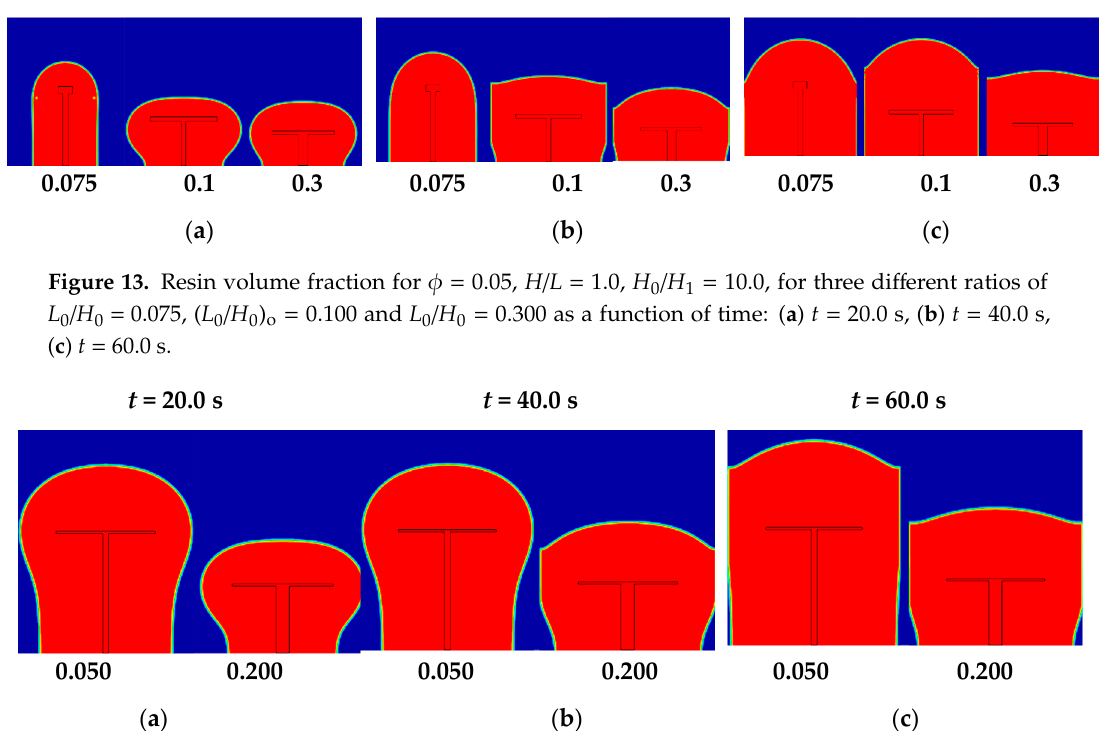
Figure 14. Resin volumetric fraction for ϕ = 0.05, H / L = 1.0, H 0 / H 1 = 30.0, for two different ratios of ( L 0 / H 0 ) oo = 0.050 and L 0 / H 0 = 0.200 as a function of time: a) t = 20.0 s, b) t = 40.0 s, c) t = 60.0 s.